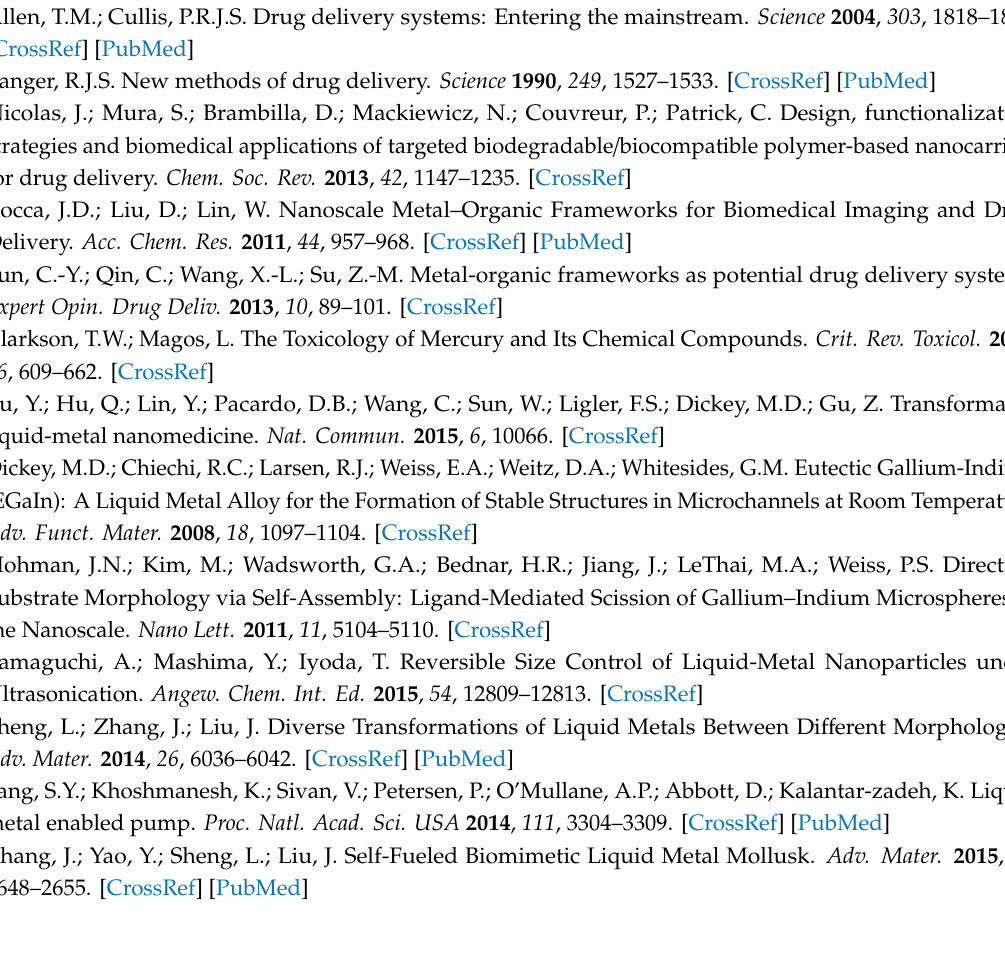
Figure S1: Transmission electron microscopy (TEM) images of LM / DSPC, Figure S2: Field Emission Scanning Electron Microscope (FE-SEM) images of (a–c) LM / DSPC and (d–f) LM / DSPC / DOX, Figure S3: (a,b) Confocal microscopy of MDA-MB-231 breast cancer cell after incubation for 8 h with LM / DSPC and nuclei (blue). (c,d) Confocal laser scanning microscopy (CLSM) images of LM / DSPC / DOX and doxorubicin (red), Figure S4: Live / Dead cell viability assay. Cells were treated with (a) doxorubicin and (b) LM / DSPC / DOX, Figure S5: TEM images of morphological transformation of LM / DSPC after heating at (a–g) 70 ◦ C, (h) 60 ◦ C and (i) 50 ◦ C, Figure S6: Dynamic light scattering (DLS) analysis. Size distribution of (a) LM / DSPC / DOX before heating and (b) after heating, Figure S7: Changes in absorbance of LM / DSPC, when LM / DSPC particles passed through the membrane. (a) UV spectroscopy of LM / DSPCs. (b) Membrane passed through the LM / DSPC particles before heating (c) after heating, Figure S8: Blocking of microfluidics channels with LM (channel width 100 µ m) (a) Fluid of LM / DSPC / DOX micro / nano particles. (b) Dry the solvent at room temperature. (c) Induce the clogging of channel by heating LM / DSPC / DOX